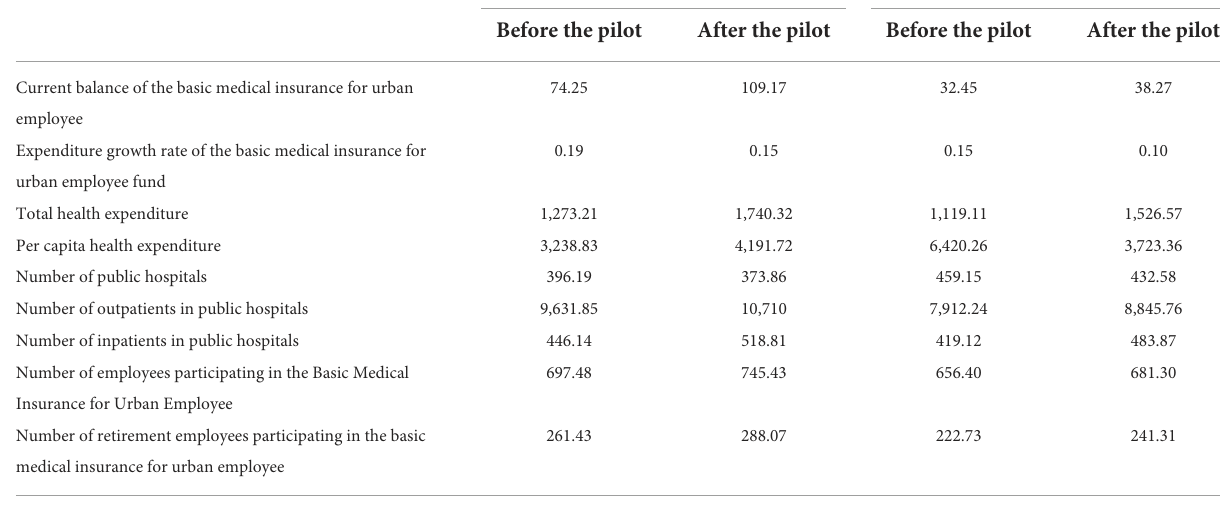
TABLE 3 Descriptive statistics of main variables.